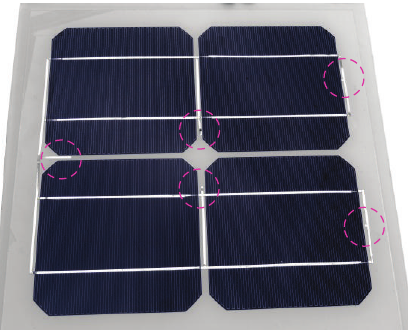
Figure 7: An experimental 4-cell mc-Si module (dashed circles mark access to external and individual cell contacts).